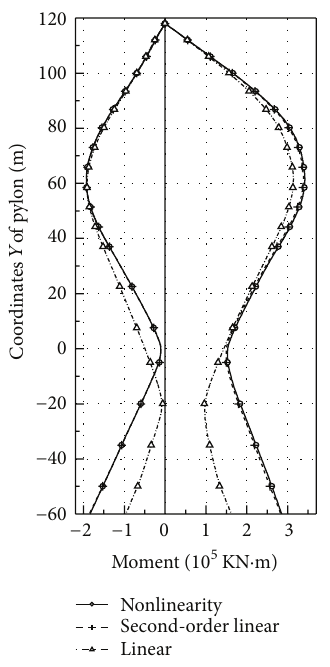
Figure 4: Envelope of pylon moment. Figure 5: Envelope of pylon displacement (positive direction pointing to mid-span).